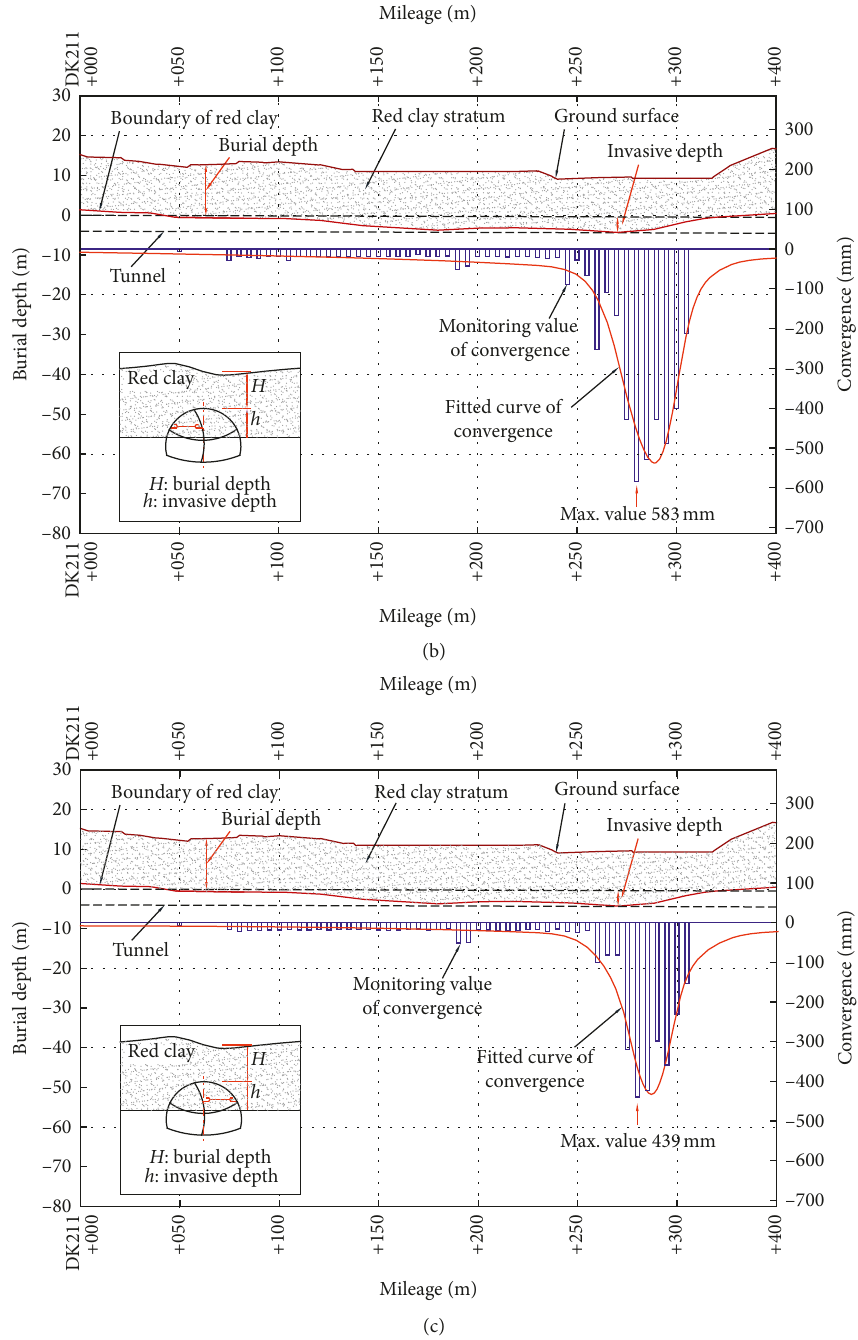
Figure 5: Distribution diagram of deformation end value along the longitudinal axis of the tunnel: (a) vault crown settlement; (b) convergence of the left pilot tunnel; (c) convergence of the right pilot